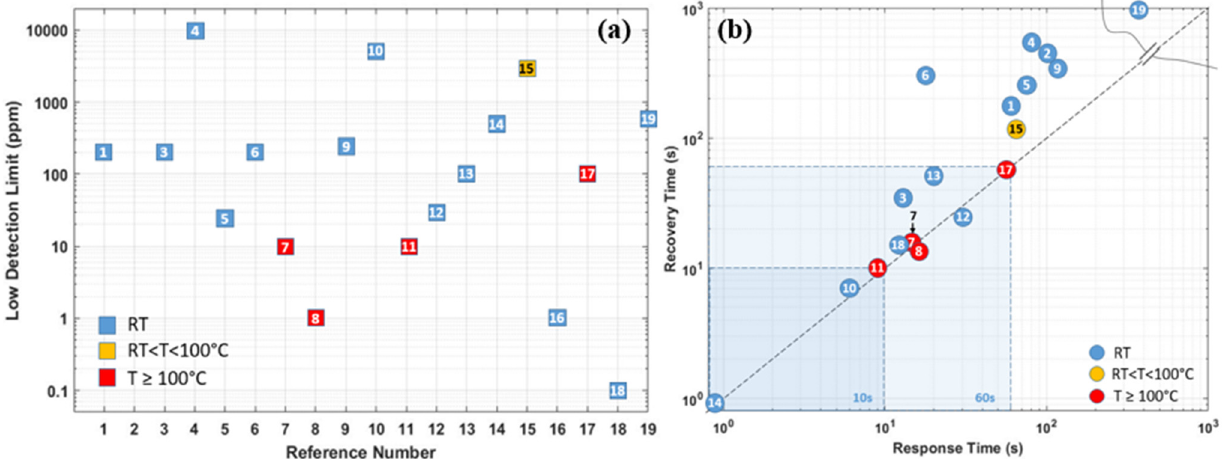
Table 3. Comparison of sensing performances towards hydrogen gas of the transition metal/graphene (e.g., GO, rGO)- based gas sensors in literature. Unless specified, the sensor response is defined by Equation (1). RT: room temperature, CVD: chemical vapour deposition, HTRJ: high-temperature reducing jet. Ref.